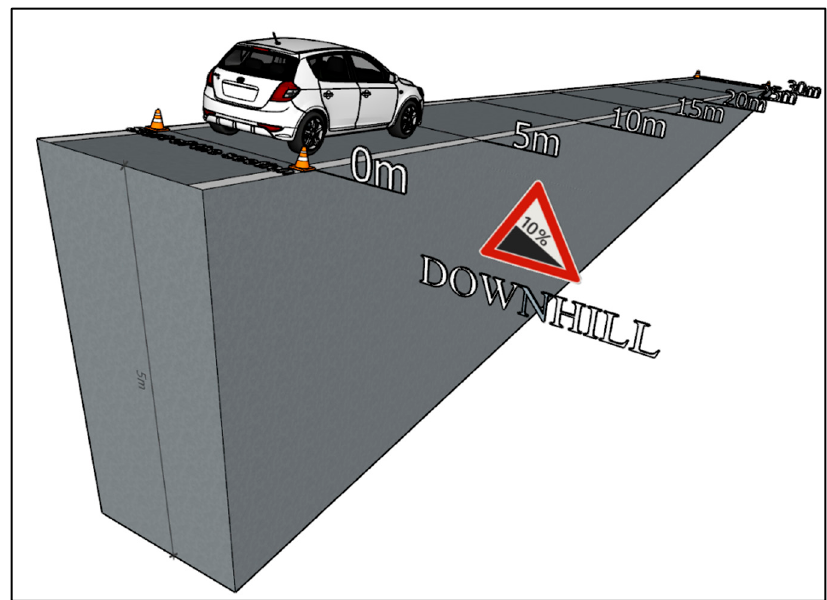
Figure 5. Measurement Visualization—Downhill [author via Sketchup].